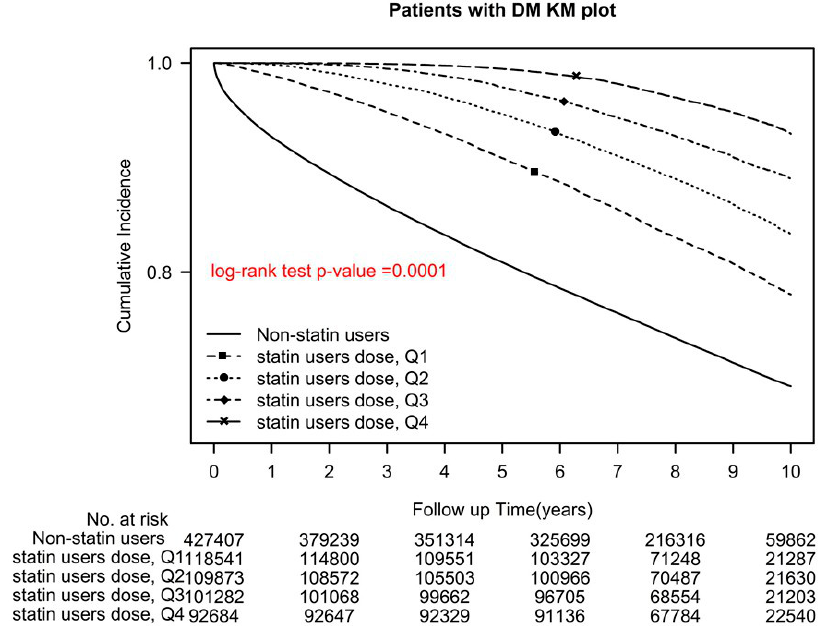
Figure 2. Kaplan–Meier overall survival curves of patients with type 2 diabetes who used different cDDD-year of statins.